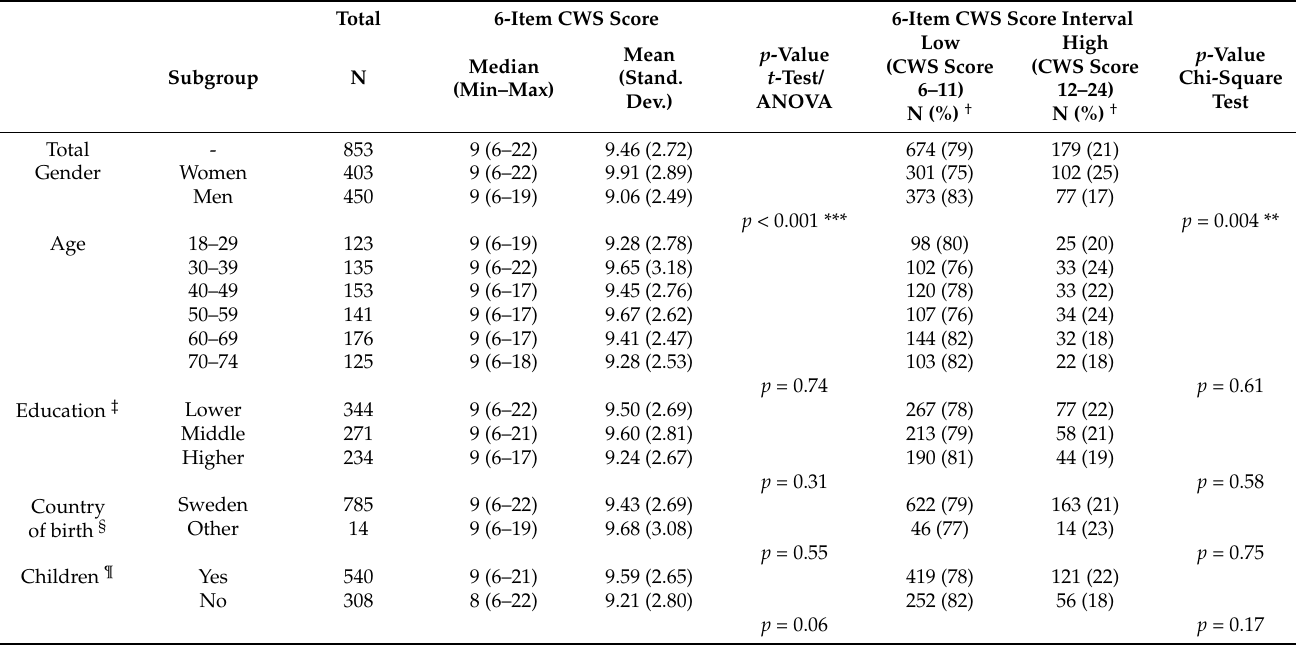
Table 1. Six-item CWS score in participants without personal cancer history in a population-based sample ( n = 853).